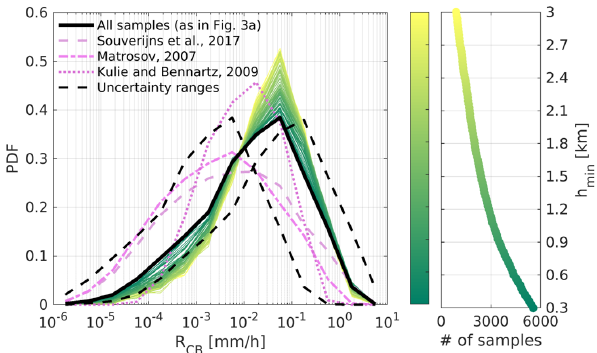
Figure B1. The PDF of R CB over all sampled NSA cases (solid black; as in Fig. 3a); dashed black curves denote the PDF using R CB at its uncertainty range edges over all samples (as in Fig. 3a). The pink curves show PDFs of R CB calculated using Z e – R re- lationships derived by Souverijns et al. (2017; for snowfall rate), Kulie and Bennartz (2009; for aggregates and bullet rosettes above and below − 20 ◦ C, respectively), and Matrosov (2007; for dendritic aggregates) (see legend for details). The color-scaled curves show the PDFs calculated using the same R CB calculation method as in the text but with various lowest examined (cutoff) KAZR altitudes ( h min ); the right panel shows the number of samples for every h min